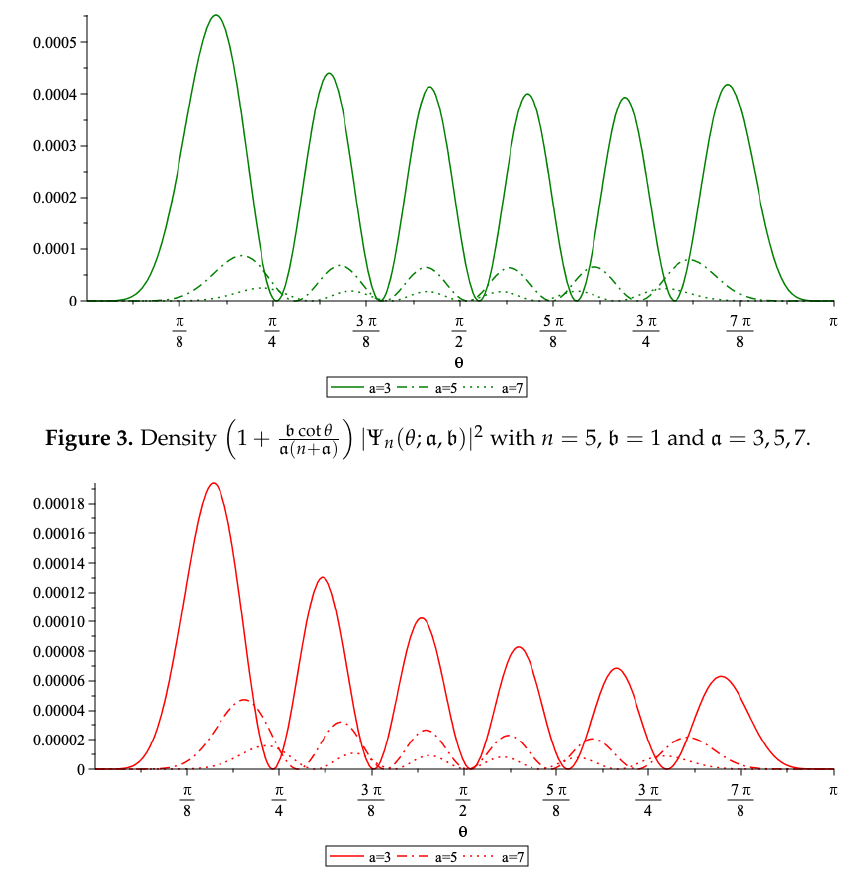
Figure 4. Density | Φ n ( θ ; a , b ) | 2 with n = 5, b = 1 and a =